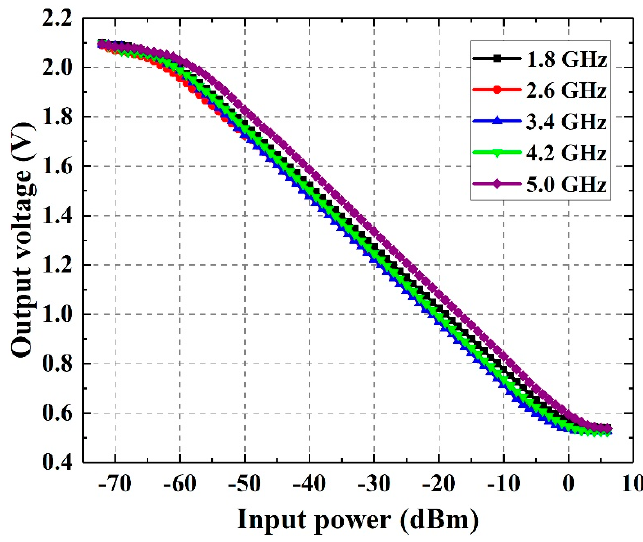
Figure 5. Relationship of the input power with the output voltage.